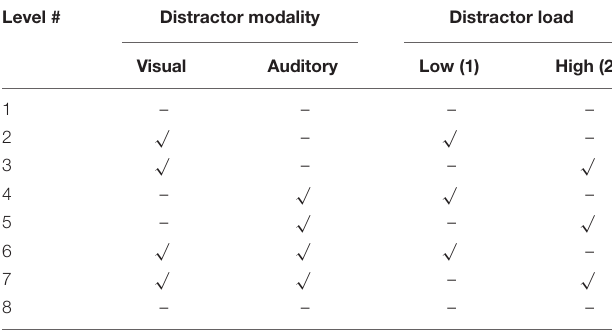
TABLE 1 | The levels of the MOXO-CPT in terms of distractor modality and